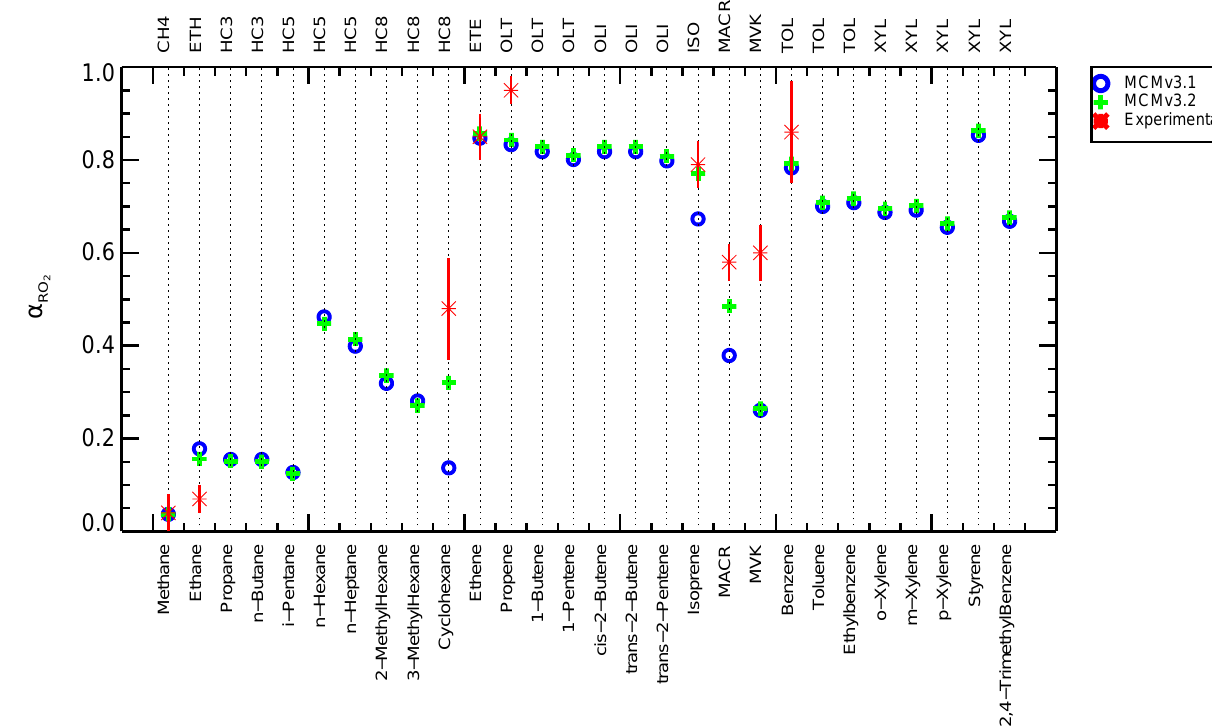
Fig. 3. Relative detection sensitivities ( α i ) for specific RO 2 compared to HO 2 . The experimental values (red stars) and their 1 σ error bars were determined for the instrument configuration applied at PRD for HO 2 detection (Fuchs et al., 2011). Modelled values (blue circles for MCMv3.1 and green crosses for MCMv3.2) are shown for major VOCs which contributed more than 90% to the VOC reactivity in PRD. Original and mechanistic names of the VOCs are shown at the lower and upper x-axis, respectively.